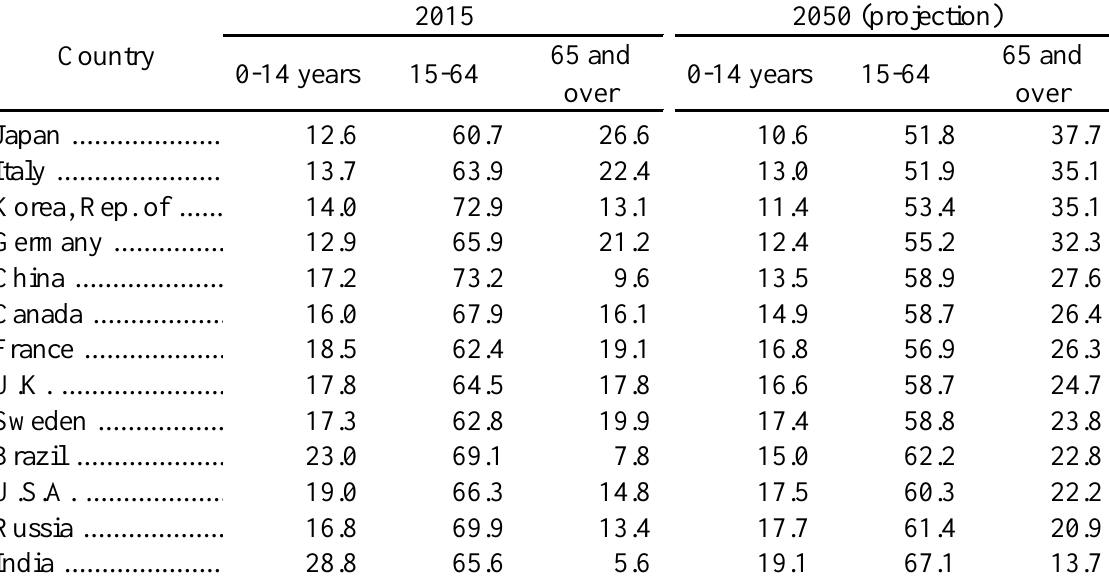
Table 2.5 Age Structure of Population by Country 2015 2050 (projection) 65 and Country 0-14 years over